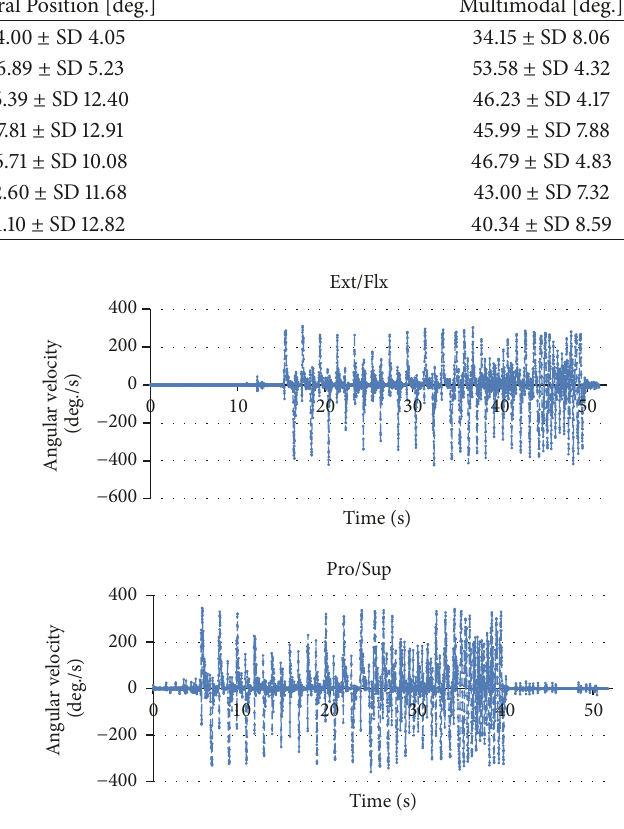
Figure 16: Angular velocity of powered 2-DOF wrist. Table 4: Maximum value of powered 2-DOF wrist angular